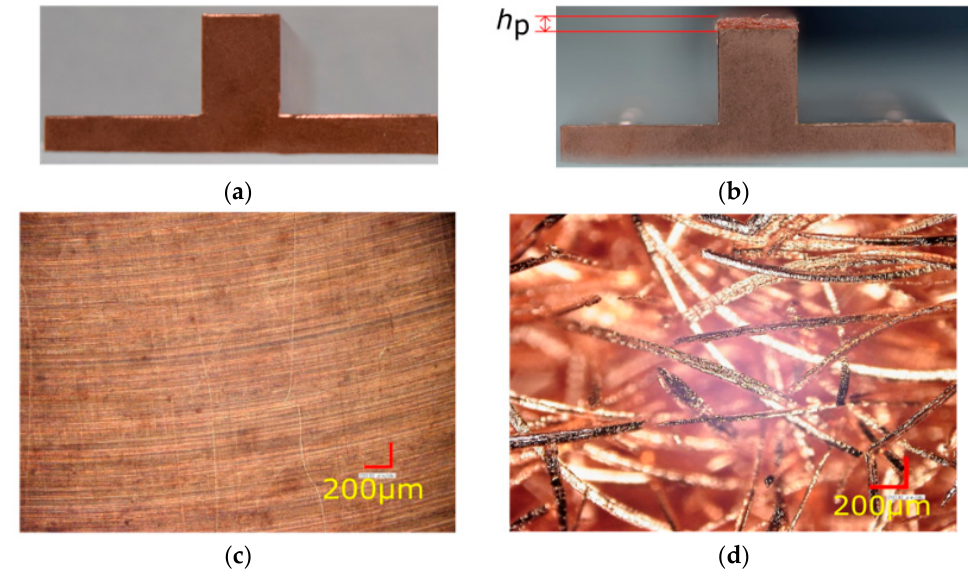
Figure 3. Test section: ( a ) bare test section, ( b ) high porosity test section, ( c ) microscopic view (×100) of the bare test section, ( d ) microscopic view (×100) of the high porosity test section.